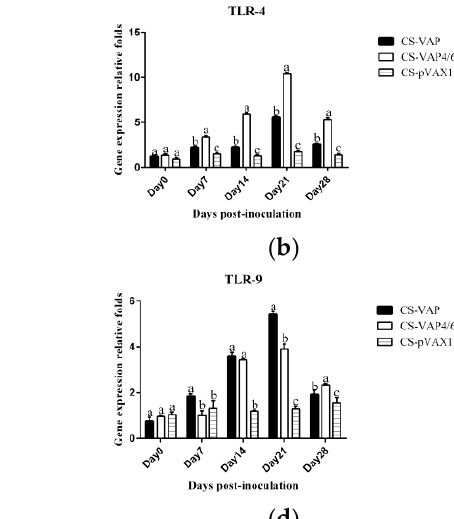
( c ) Figure 7. Changes of IgG ( a ), IgG1 ( b ), and IgG2a ( c ) levels of the experimental mice. The IgG, IgG1, and IgG2a levels of each treated group are higher than that of the control group from day 7 to day 28 post-inoculation.